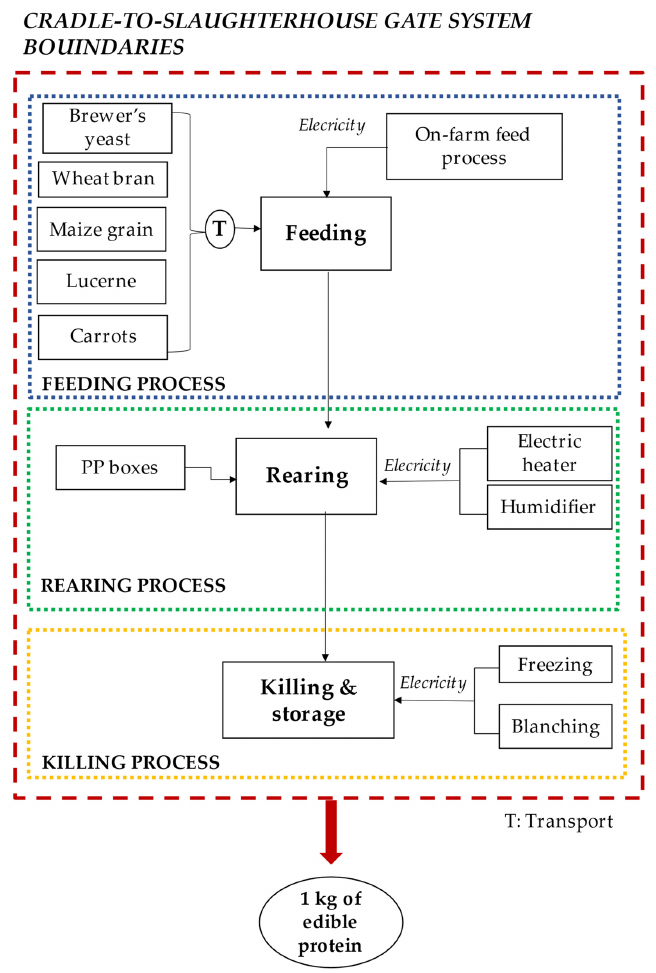
Figure 1. The system boundaries for mealworm production.